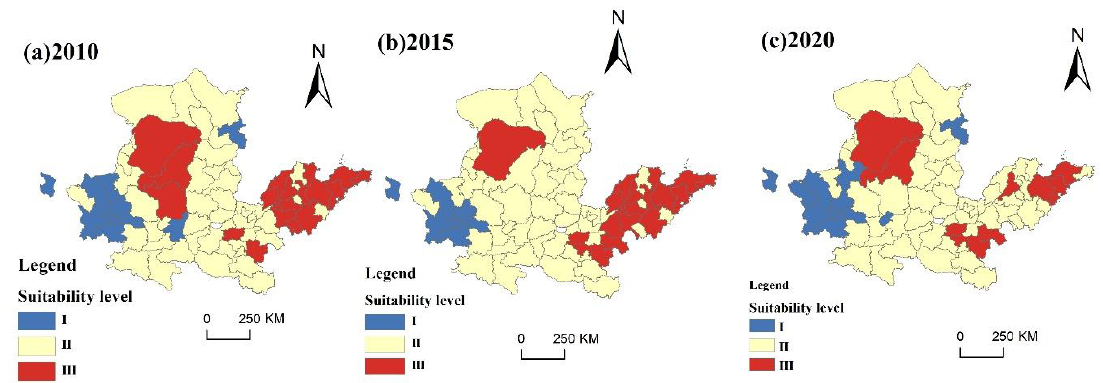
Figure 6. Spatial and temporal patterns of production suitability grades from 2010 to